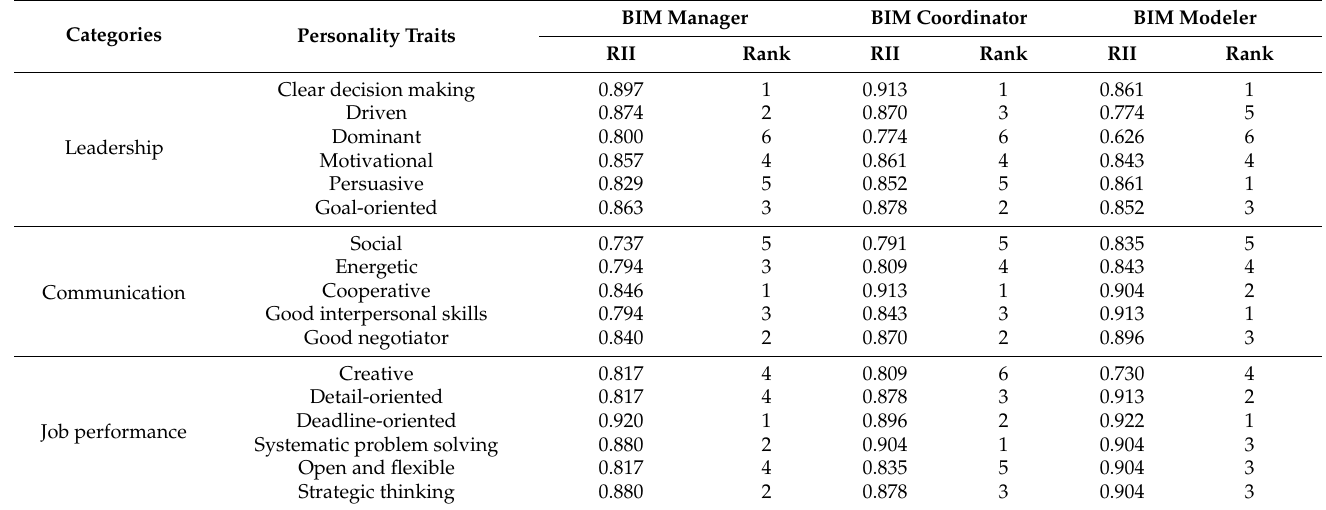
Table 5. The importance level of personality traits in relation with roles and responsibilities, ranked by BIM